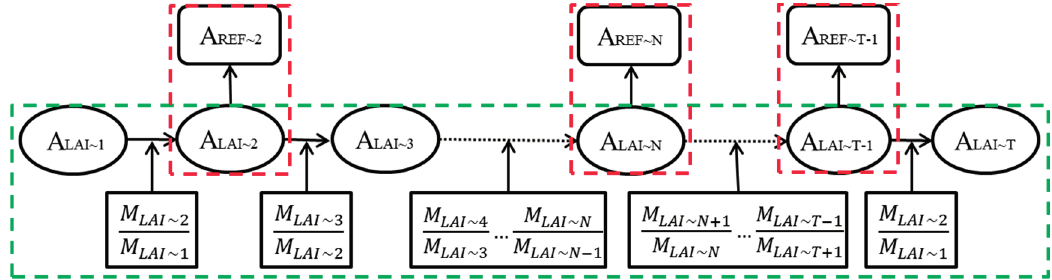
Figure 3. The schematic diagram for dynamic Bayesian network